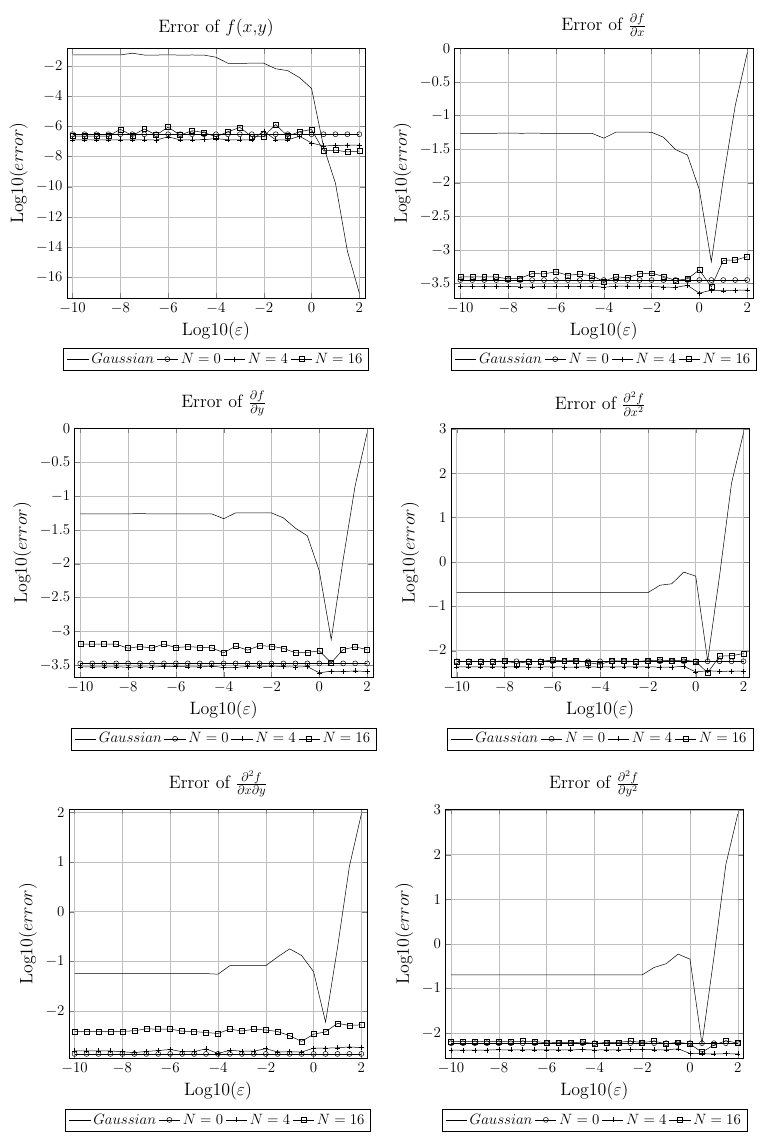
Figure 3. Error of approximating the specified function f ( x , y ) and its derivatives using the Gaussian RBF approach and Hermite expansion approach as they vary with ε . The number of mesh points is fixed at 900, they are randomly distributed within the range [ −